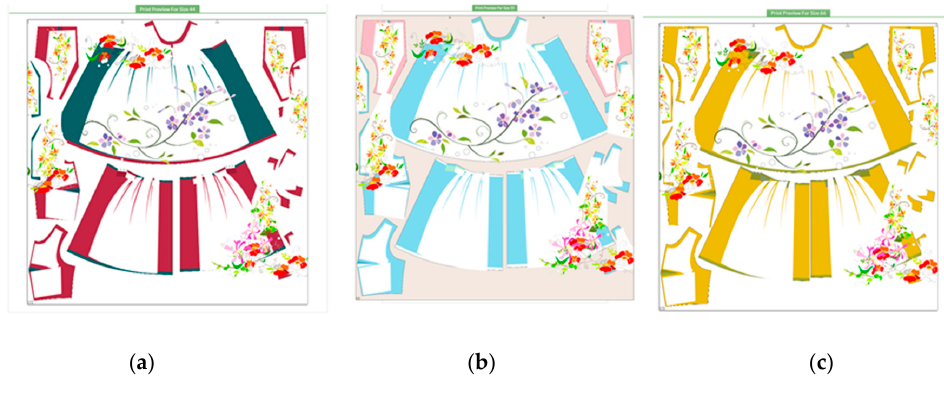
Figure 18. Apply size result. ( a ) Size S ( b ) Size M ( c ) Size L.